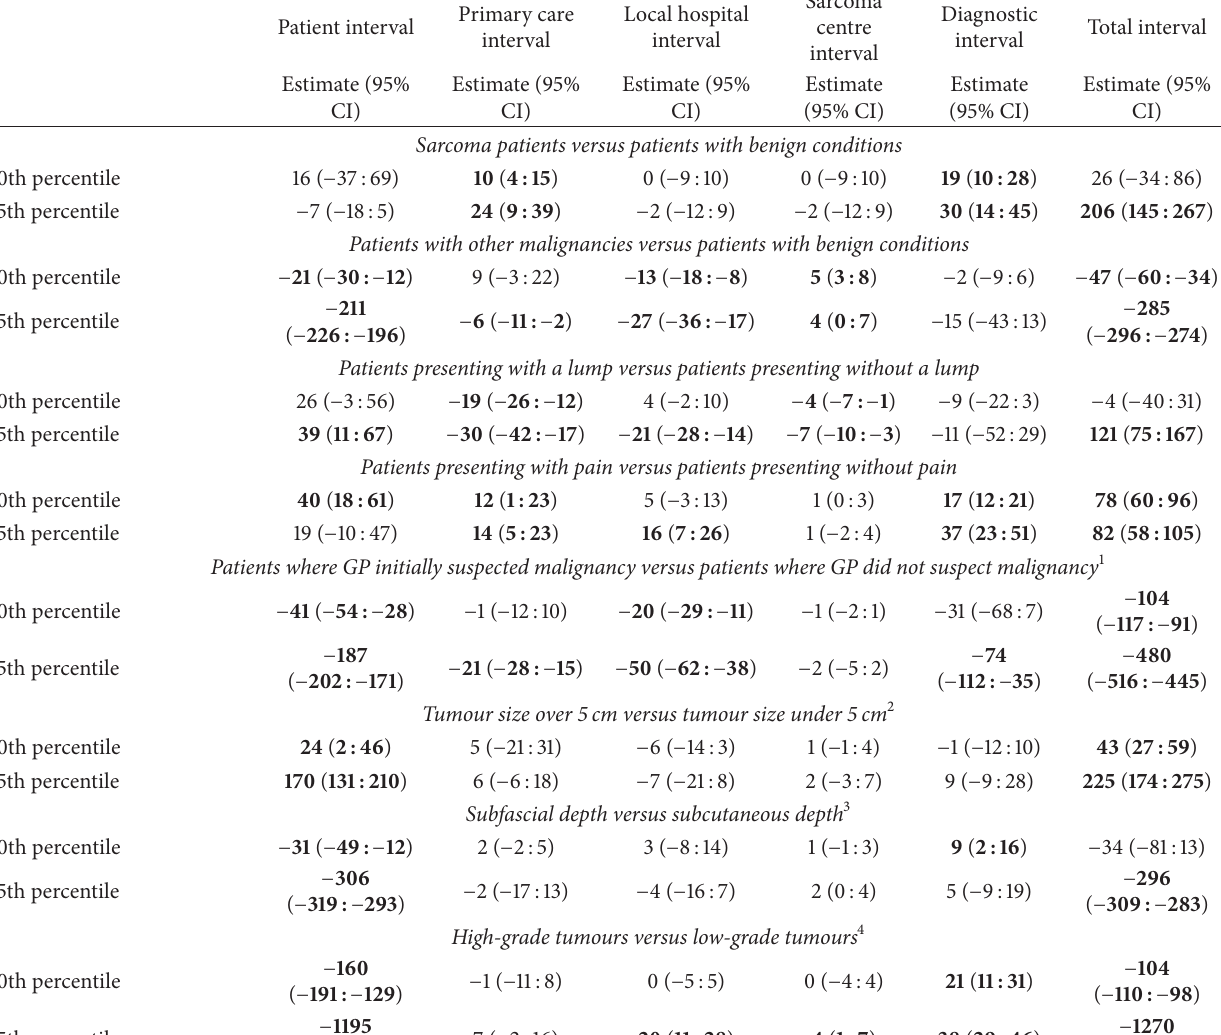
Table 6: Estimated differences in time intervals at the 50th and 75th percentiles, measured as difference in calendar days with 95% confidence intervals (CI), calculated by quantile regression.